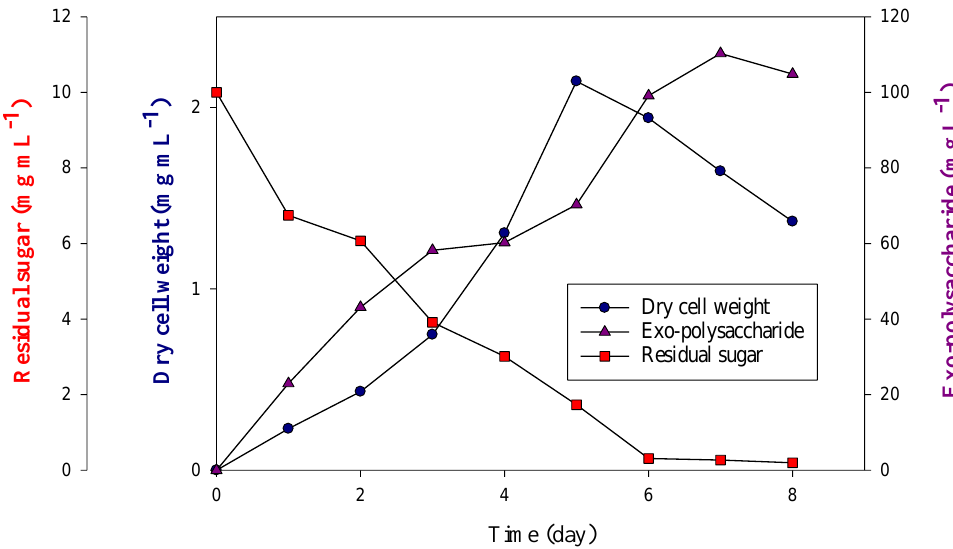
Figure 3. The effect of Tween 80 at 0 g/L on mycelia growth and EPS production in in a 5 − L stirred tank bioreactor.